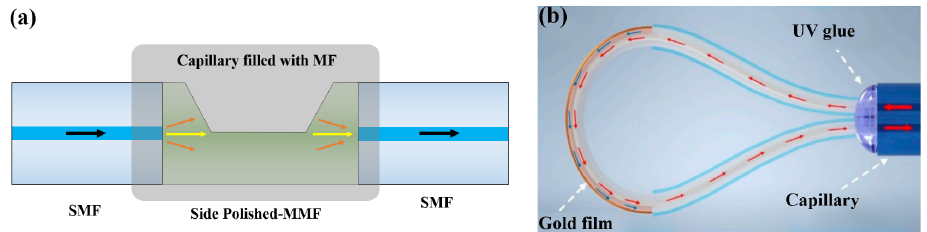
Figure 9. Magnetic fiber sensors based on ( a ) a side-polished fiber [71] and ( b ) a U-shape macro- bending fiber (reprinted with permission from Ref. [75], 2022, MDPI).